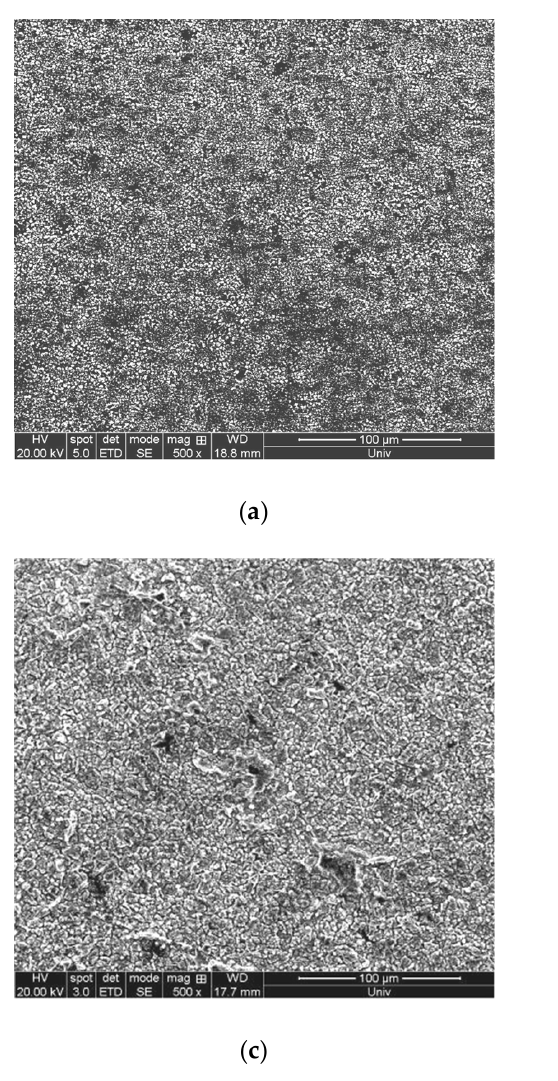
Figure 5. Surface morphology of the specimen obtained from the variation of the sample matrix and molten salt NaF content: ( a ) X NaF = 0.2 ( b ) X NaF = 0.3 ( c ) X NaF = 0.4 ( d ) matrix.